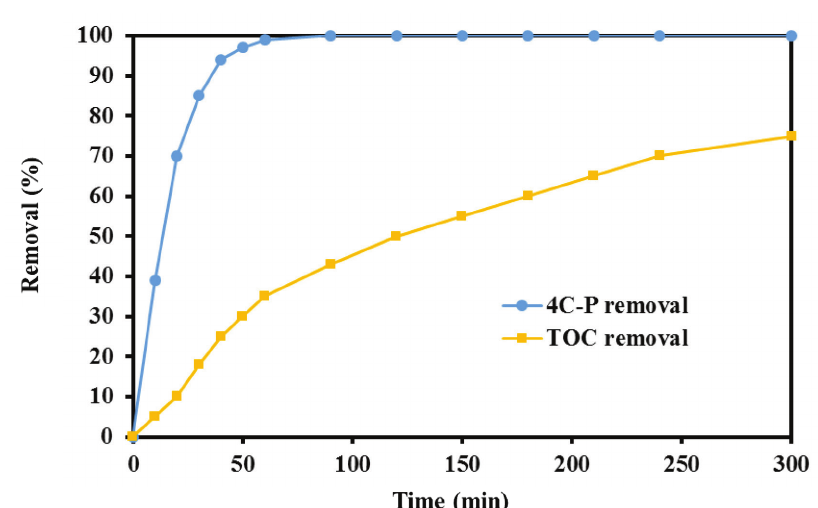
Fig. 11 – Mineralization rate of 4-CP using CWPO/US-Fe